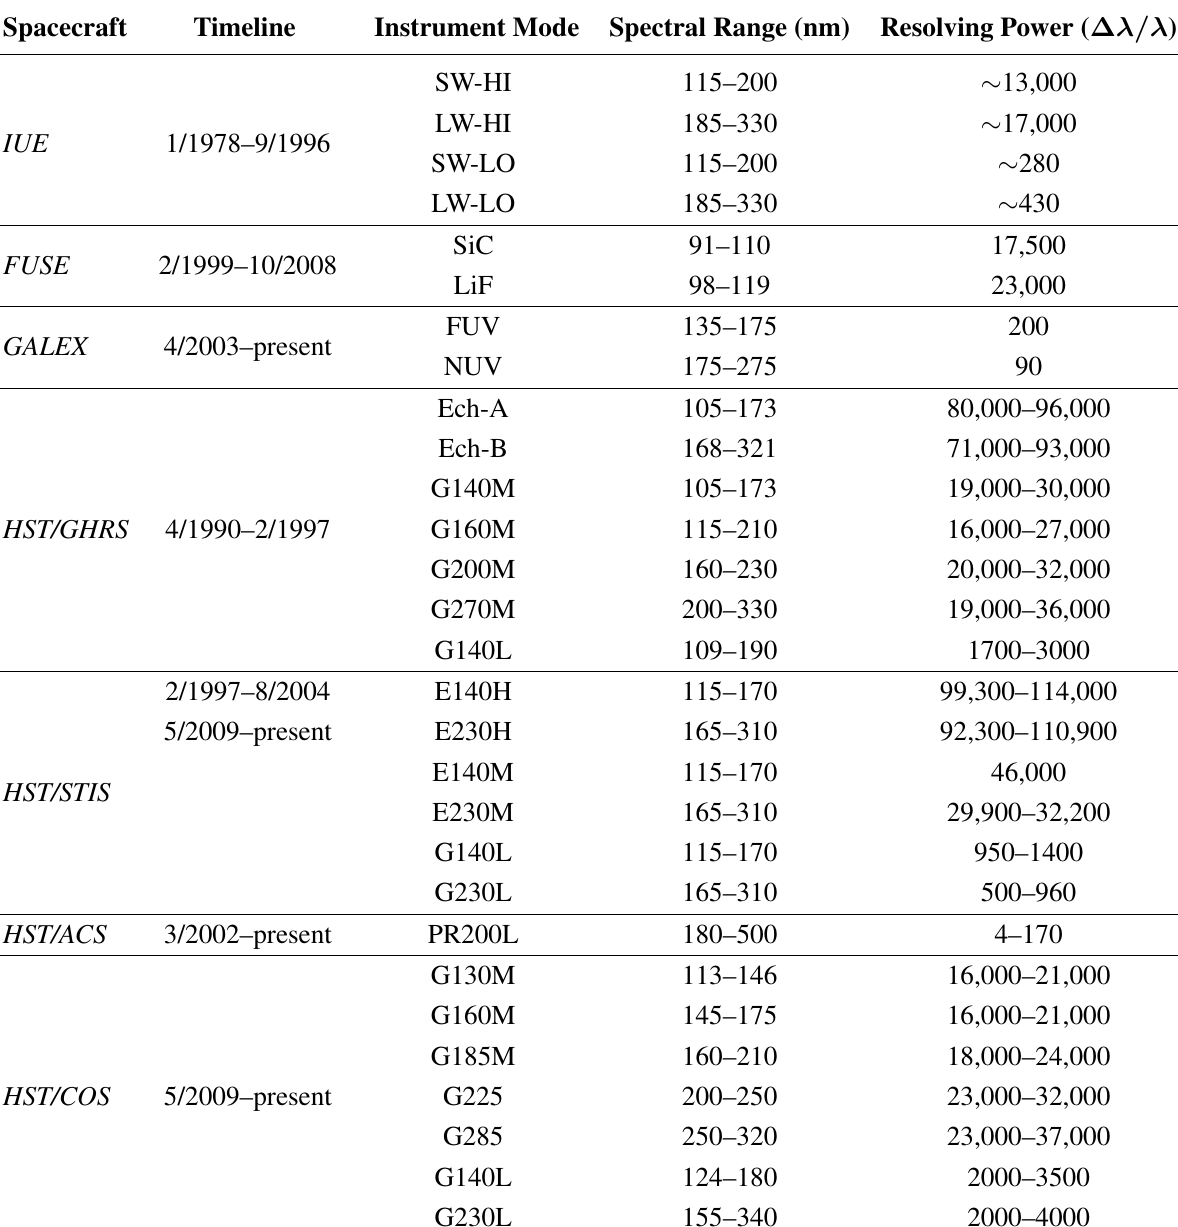
Table 1. Spectroscopic Properties of Ultraviolet